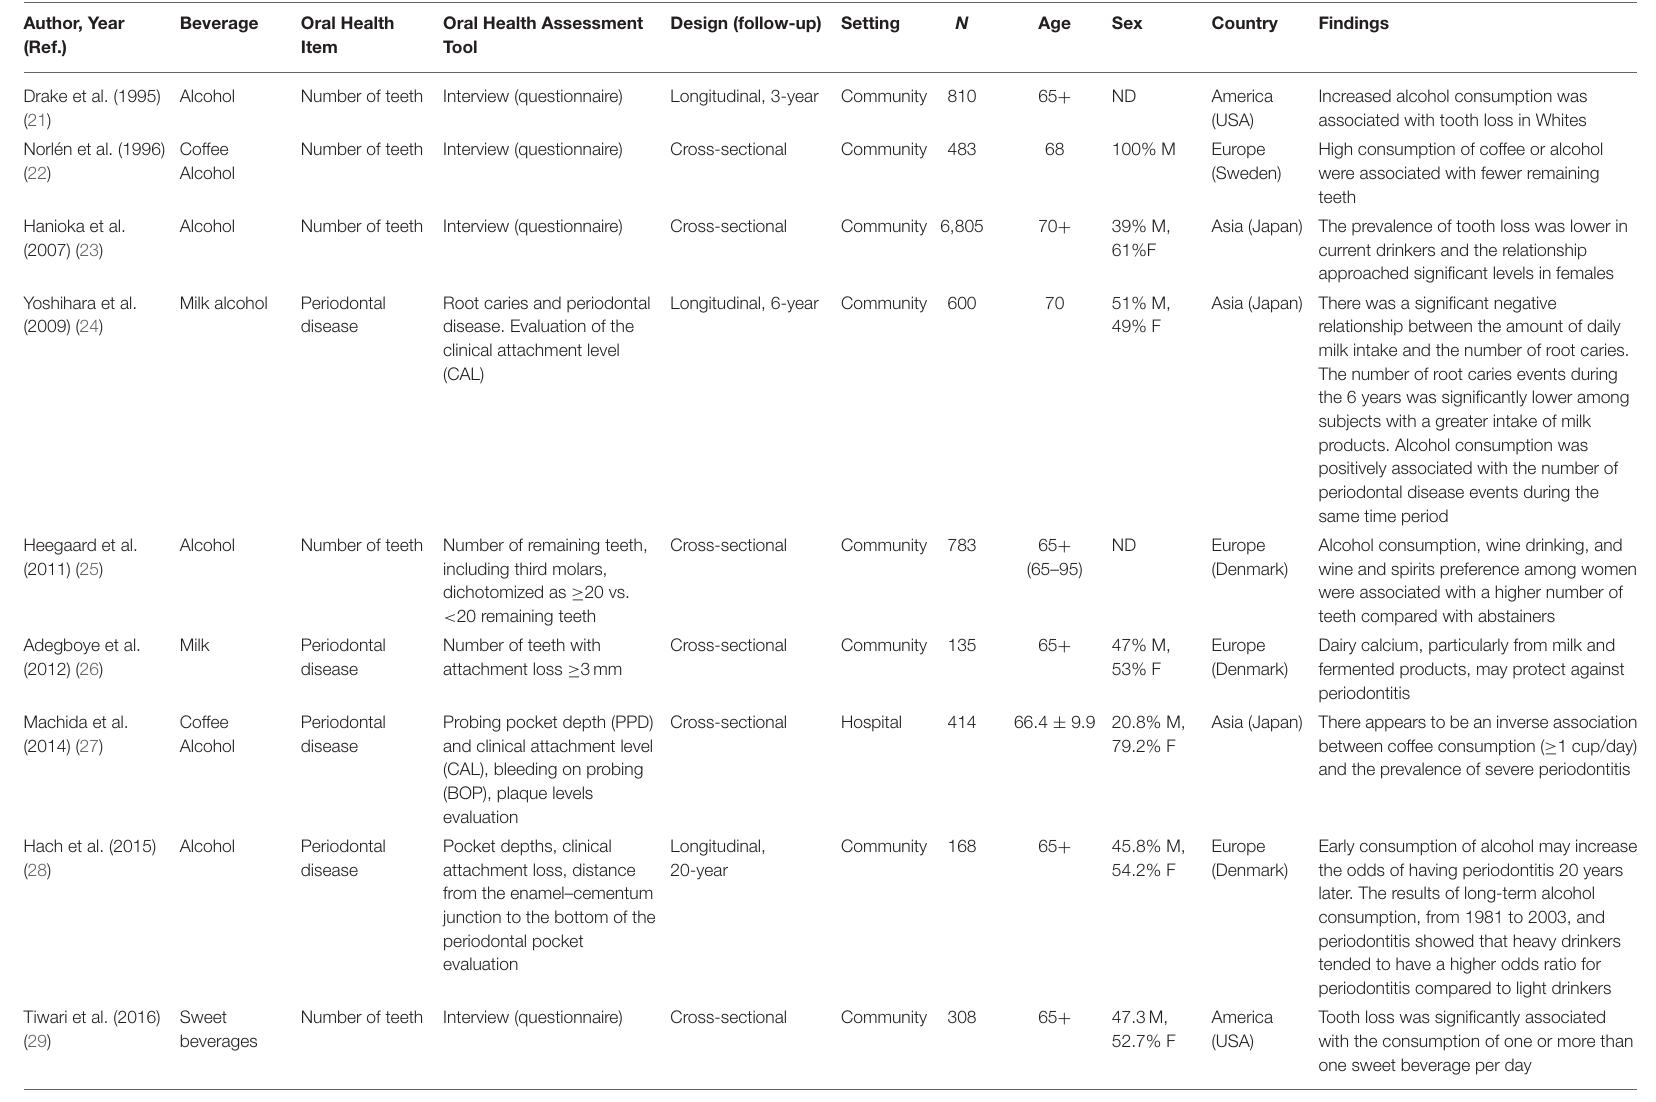
TABLE 1 | Selected studies investigating beverage consumption and oral health status in older age ( N = 12). Author, Year